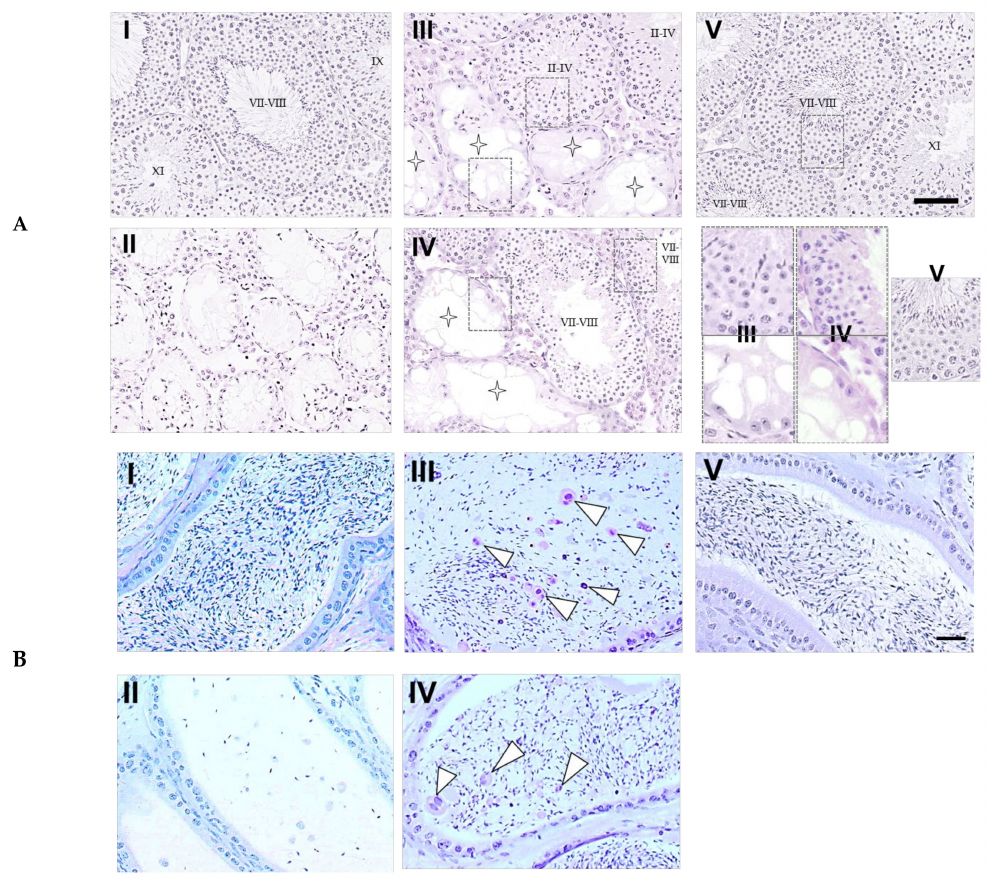
Figure 3. Testicular and epididymal sections from mice after BSF treatment followed by diet supplementation with Hachimi-jio-gan and / or Hochu-ekki-to. ( A ) Intact seminiferous tubules exhibiting all the stages of maturation of the germinal epithelium from spermatogonia to spermatozoa have been shown in the control group (I). Atrophic seminiferous tubules with azoospermia have been shown in the BSF group (II). Atrophic seminiferous tubules with aspermatogenesis (star pattern) and intact seminiferous tubules with spermatogenesis were observed in the BSF-treated mice administered with TJ7 (III) or TJ41 (IV) alone. Seminiferous tubules of normal appearance were observed in the BSF-treated mice co-administered with TJ7 and TJ41 (V). Enlarge part of seminiferous tubules bounded by dotted frames showed germinal epithelium of normal spermatognesis or aspermatogenesis. Scale bar = 50 µ m. ( B ) Epididymal spermatozoa in the epididymal tubules of cauda epididymidis. The arrow heads indicate abnormal form of sperm. Spermatozoa with normal morphology appeared in the epididymal tubule in the control group (I). Only very few spermatozoa (and these did not have tails) were observed in the epididymal tubules in the BSF-treated mice (II). A loss of sperm density with some abnormal forms of spermatozoa (arrow heads) was observed in the BSF-treated mice administered with TJ7 (III) or TJ41 (IV) alone. Spermatozoa exhibited normal morphology and were present at high densities in the epididymal tubule in the BSF-treated mice co-administered with TJ7 and TJ41 (V). Scale bar = 50 µ m. The epididymal spermatozoa were also analyzed (Figure 3B), and mature spermatozoa with normal morphology were observed in the epididymal tubules of cauda epididymidis in the control mice. In the BSF-treated mice, only very few spermatozoa (and these did not have tails) were detected in the epididymal tubules of cauda epididymidis. In mice that received TJ7 or TJ41 alone, the spermatozoa were sparse and some abnormal spermatozoa were detected, but the pathology was less severe compared with that in the BSF-treated mice that did not receive either drug. The co-administration of both TJ7 and TJ41 restored normal epididymal morphology, and the spermatozoa densities were returned to the high levels observed in the control